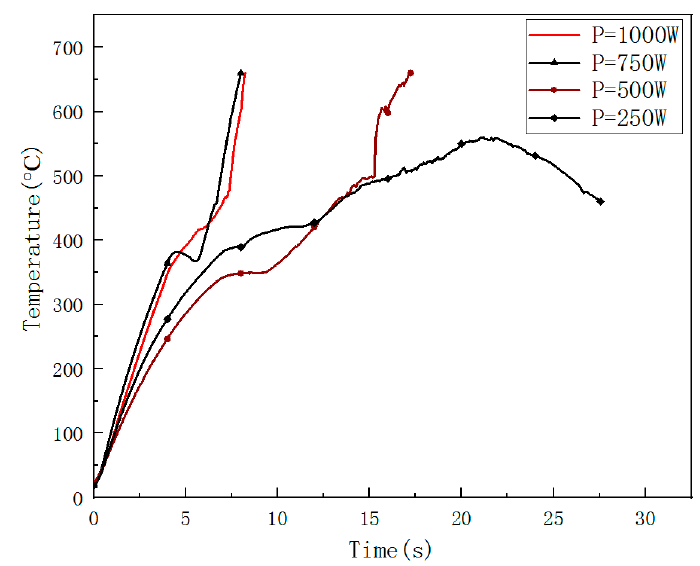
Figure 17. The temperature curve of the central point at CFRP laminated rear surface.